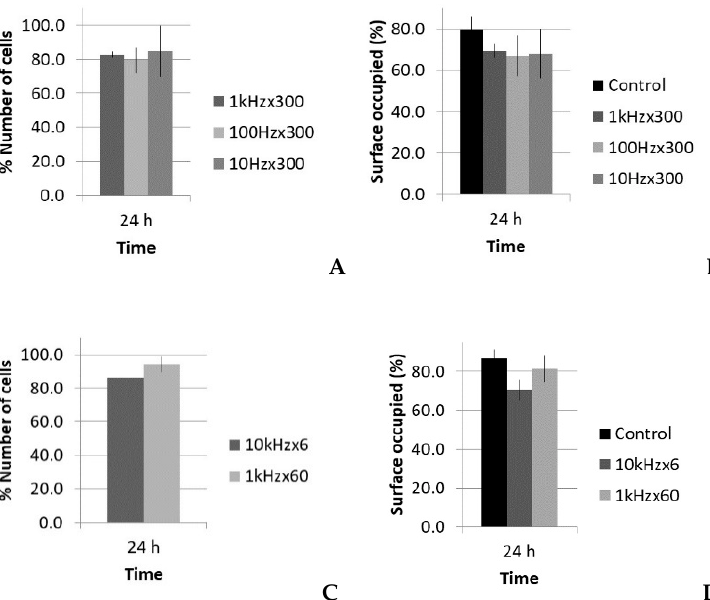
Figure 9. Number of cells and surface occupied (%), with respect to the control, 24 h after treatment of fibroblasts with the short pulse protocol: ( A , B ) groups with the same total time of sonication (300 s) and ( C , D ) groups with the same total energy (60,000 pulses).